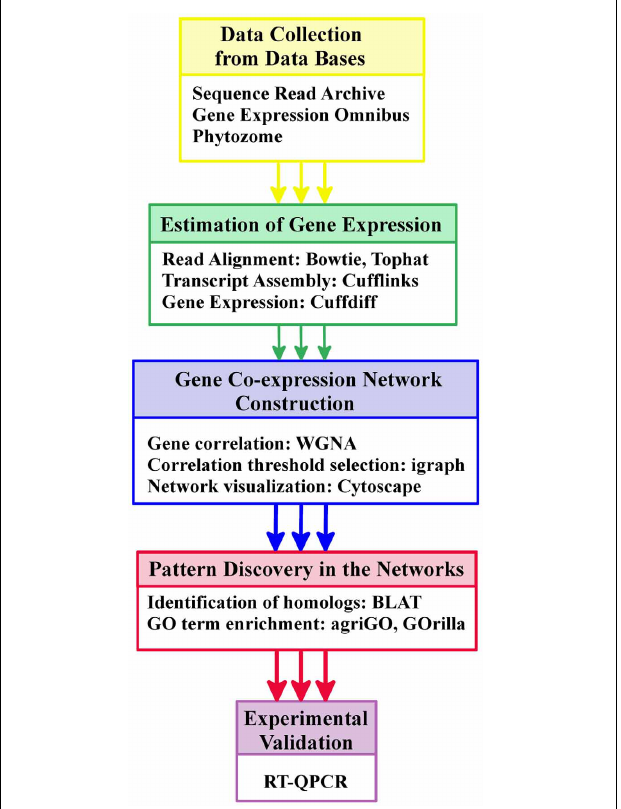
FIGURE 1 | Schematic workflow including data collection and processing as well as gene co-expression network construction, analysis and validation. The figure simplifies the main steps followed in the workflow for the construction and analysis of the co-expression networks for Chlamydomonas , Physcomitrella , and Arabidopsis . This workflow requires a reference genome and the corresponding Gene Ontology annotation for each species. The annotation was obtained from the Phytozome database. Gene expression estimation measured in FPKM was obtained by aligning short reads to the reference genome and assembling transcripts using Tophat and Cufflinks . Gene correlation and network construction were performed with different Bioconductor R packages. Cytoscape was used for network visualization. Functional patterns in the neighborhoodof the genes of interest were identified with the web tools agriGO and GOrilla . Finally, Q-PCR was used for experimental validation. A detailed representation of this workflow can be seen in Figure